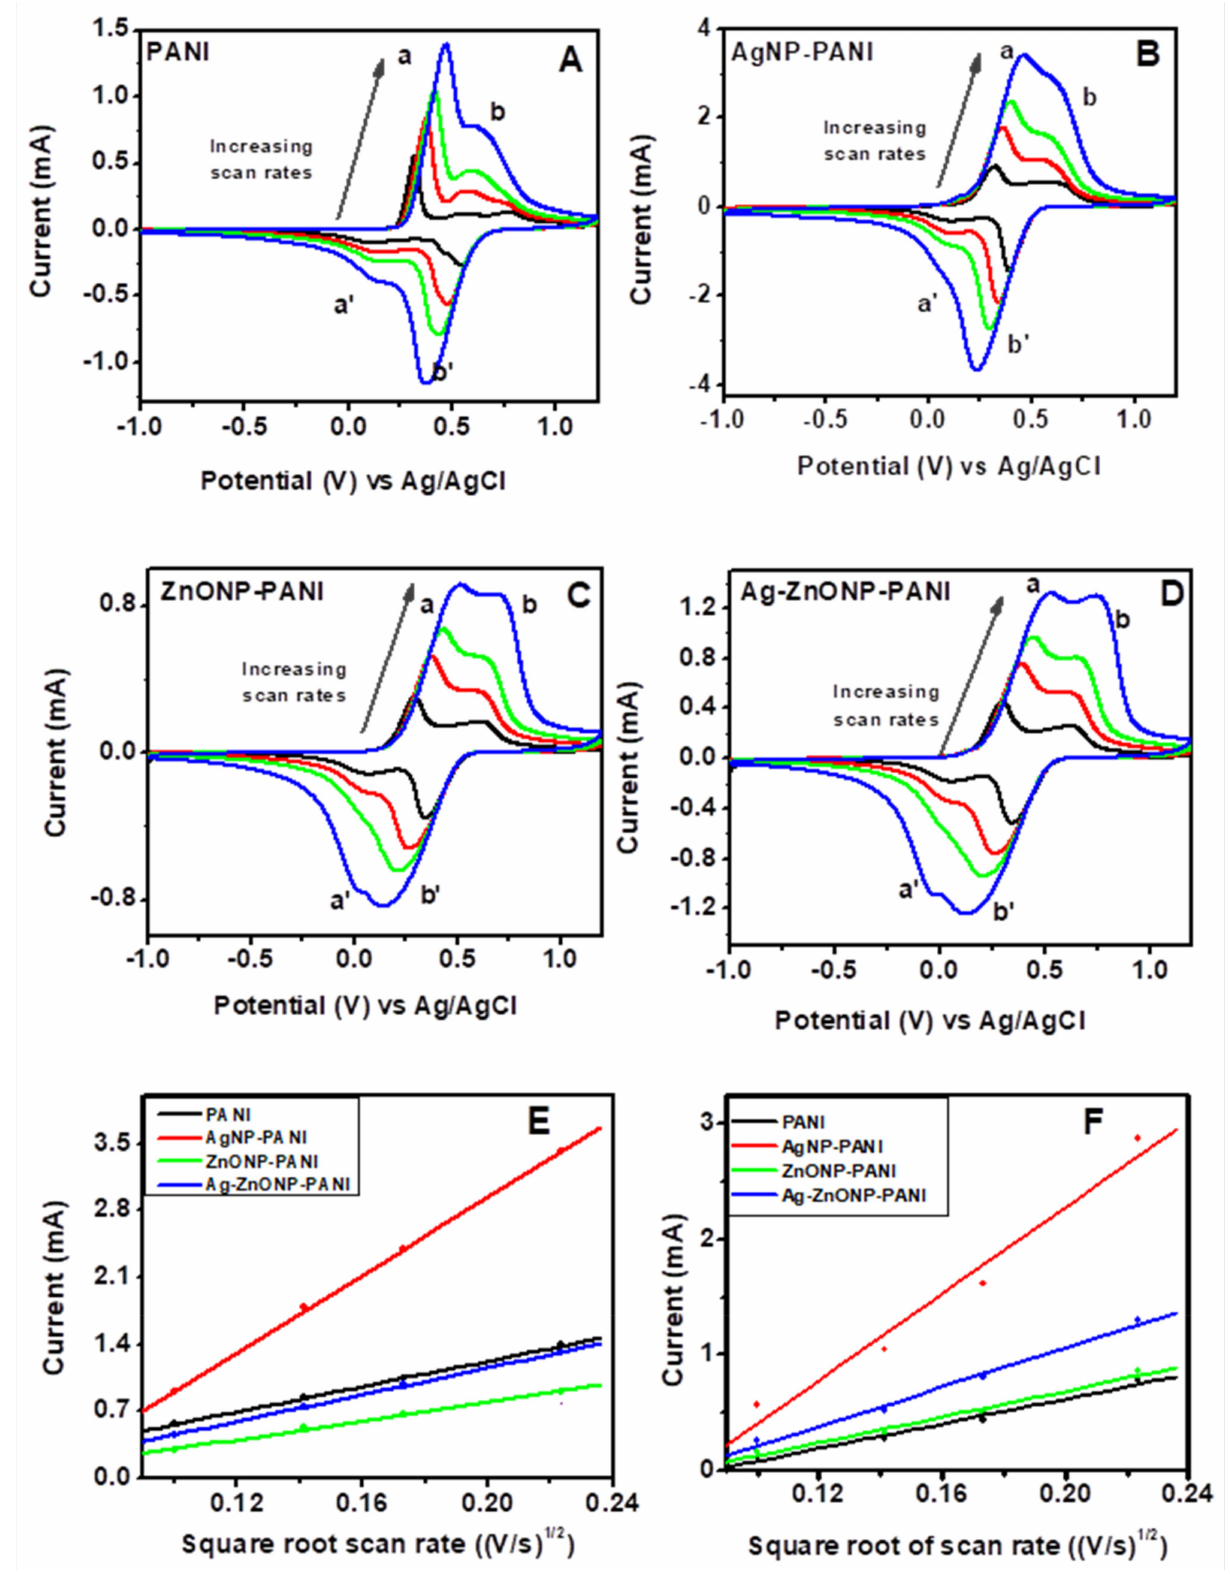
Figure 7. Scan rate-dependent cyclic voltammograms of ( A ) PANI, ( B ) AgNP-PANI, ( C ) ZnONP- PANI, and ( D ) AgZnONP-PANI (black, red, green, and blue lines represent scan rates of 10, 20, 30, and 50 mV/s, respectively). Randles–Ševˇc í k plots of the anodic peak currents of peak a (( E ): used to calculate D H+ ) and peak b (( F ): used to calculate D Cl −